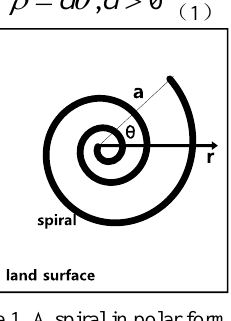
Figure 1. A spiral in polar form